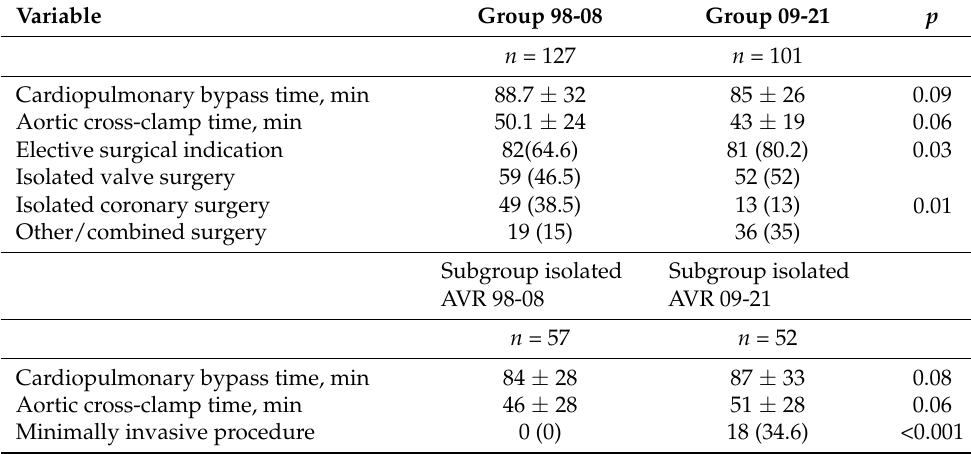
Table 2. Intraoperative